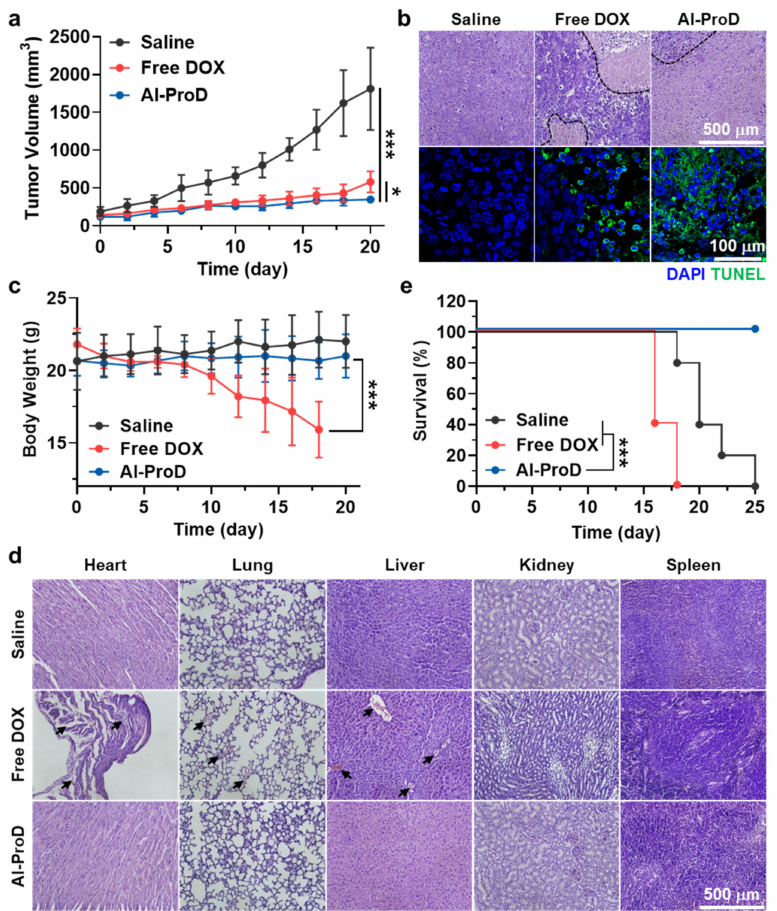
Figure 5. Antitumor efficacy and toxicity evaluation of Al-ProD. ( a ) Tumor growth curves of MDA-MB231 tumor-bearing mice after saline, free DOX, or Al-ProD treatment once every three days. ( b ) Tumor tissues stained with H&E or TUNEL to assess antitumor efficacy on day 20 after treatment. ( c ) Body weights during treatment. ( d ) Major organs stained with H&E to assess structural abnormalities on day 20 after treatment. ( e ) Mice survival during treatment. Significance (* p < 0.05 and *** p < 0.001) was determined by one-way ANOVA with the Tukey − Kramer post-hoc test ( a , c ) or log-rank test ( e